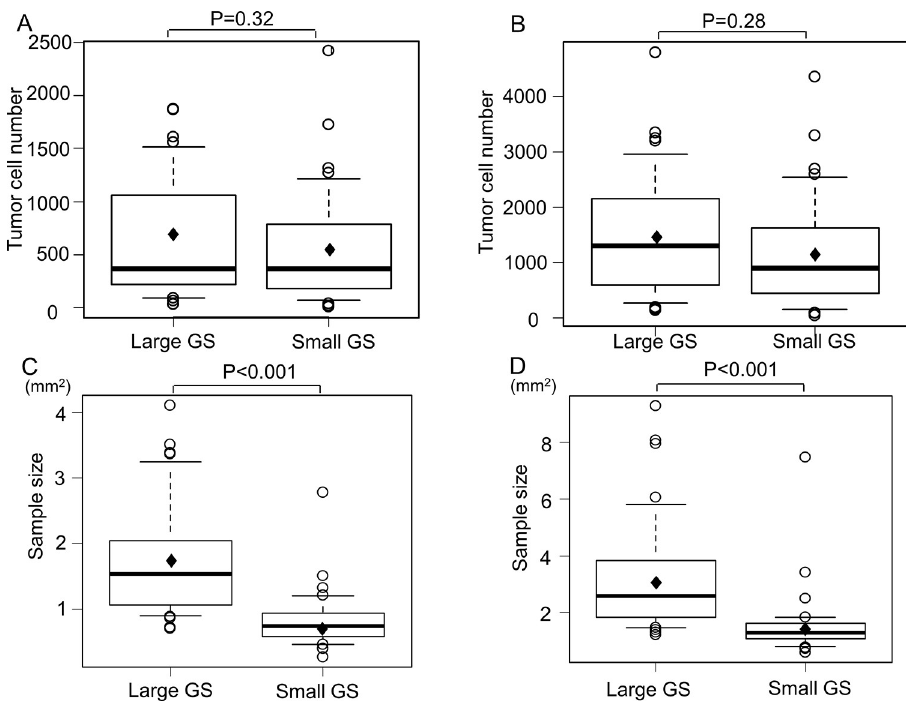
Fig 2. Tumor cell counts and sample sizes between prospective large GS group and small GS cohort. A) The comparison of the average number of tumor cells from five samples between two groups. B) The comparison of the cell counts of the sample containing the largest number of tumor cells among five samples between two groups. C) The comparison of the average sample size of five samples between two groups. D) The comparison of the largest sample size of five samples between two groups. GS; guide sheath. ◆ ; mean